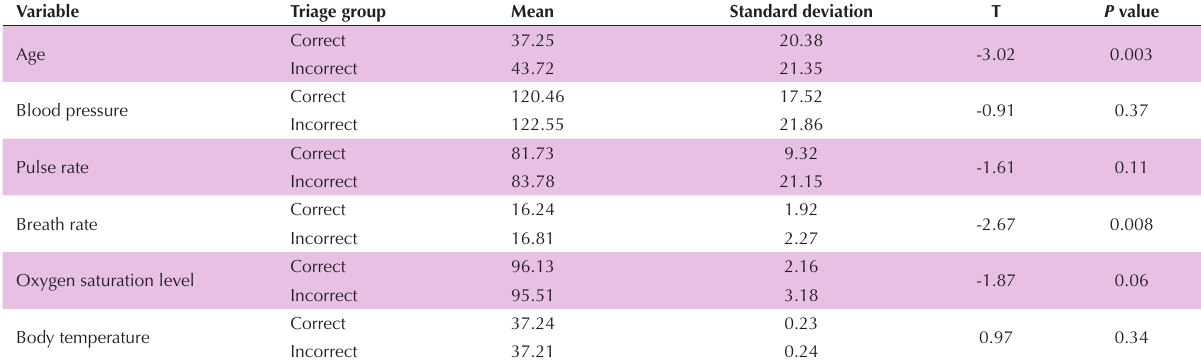
Table 2. Mean difference in vital signs